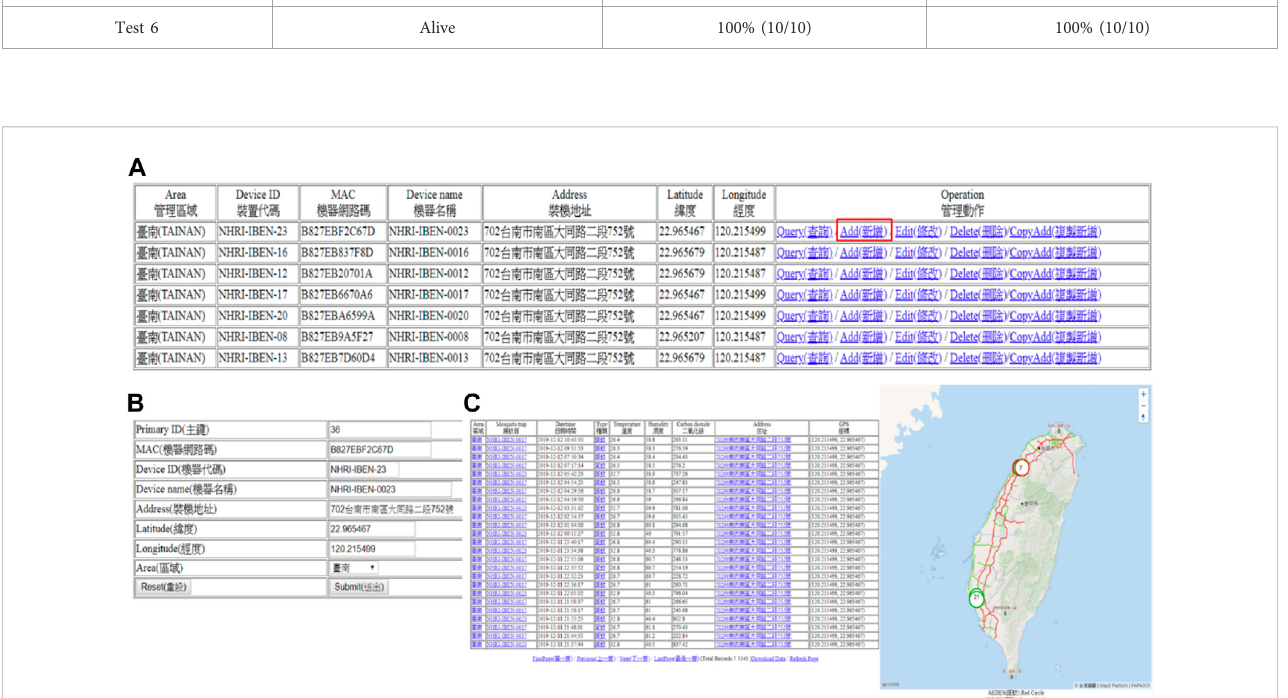
FIGURE 6 Datavisualization andtheclouddatacollectionplatform(http://mosquitotrap.nhri.org.tw/). (A) Usethemosquitotrapwebsitetoquery,add,edit,delete, and manage the data of each mosquito trap. If a new mosquito trap needs to be added to the online system, click “ Add ” on the website. (B) For the mosquito trap to be added, fi ll in the machine ’ s media access control (MAC) address, mosquito trap code, name, address, latitude and longitude, and area and click submit. (C) After adding a mosquito trap, the mosquito trap website will be updated. The table on the left side and the map on the right side display the information uploaded by the newly added mosquito trap, such as the name of the mosquito trap; the types of mosquitoes caught; the local temperature, humidity, and CO 2 concentration; and capture information such as mosquito location and GPS latitude and